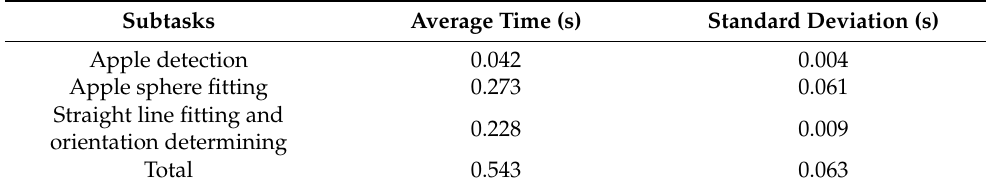
Table 4. Efficiency analysis of apple orientation determination algorithm.